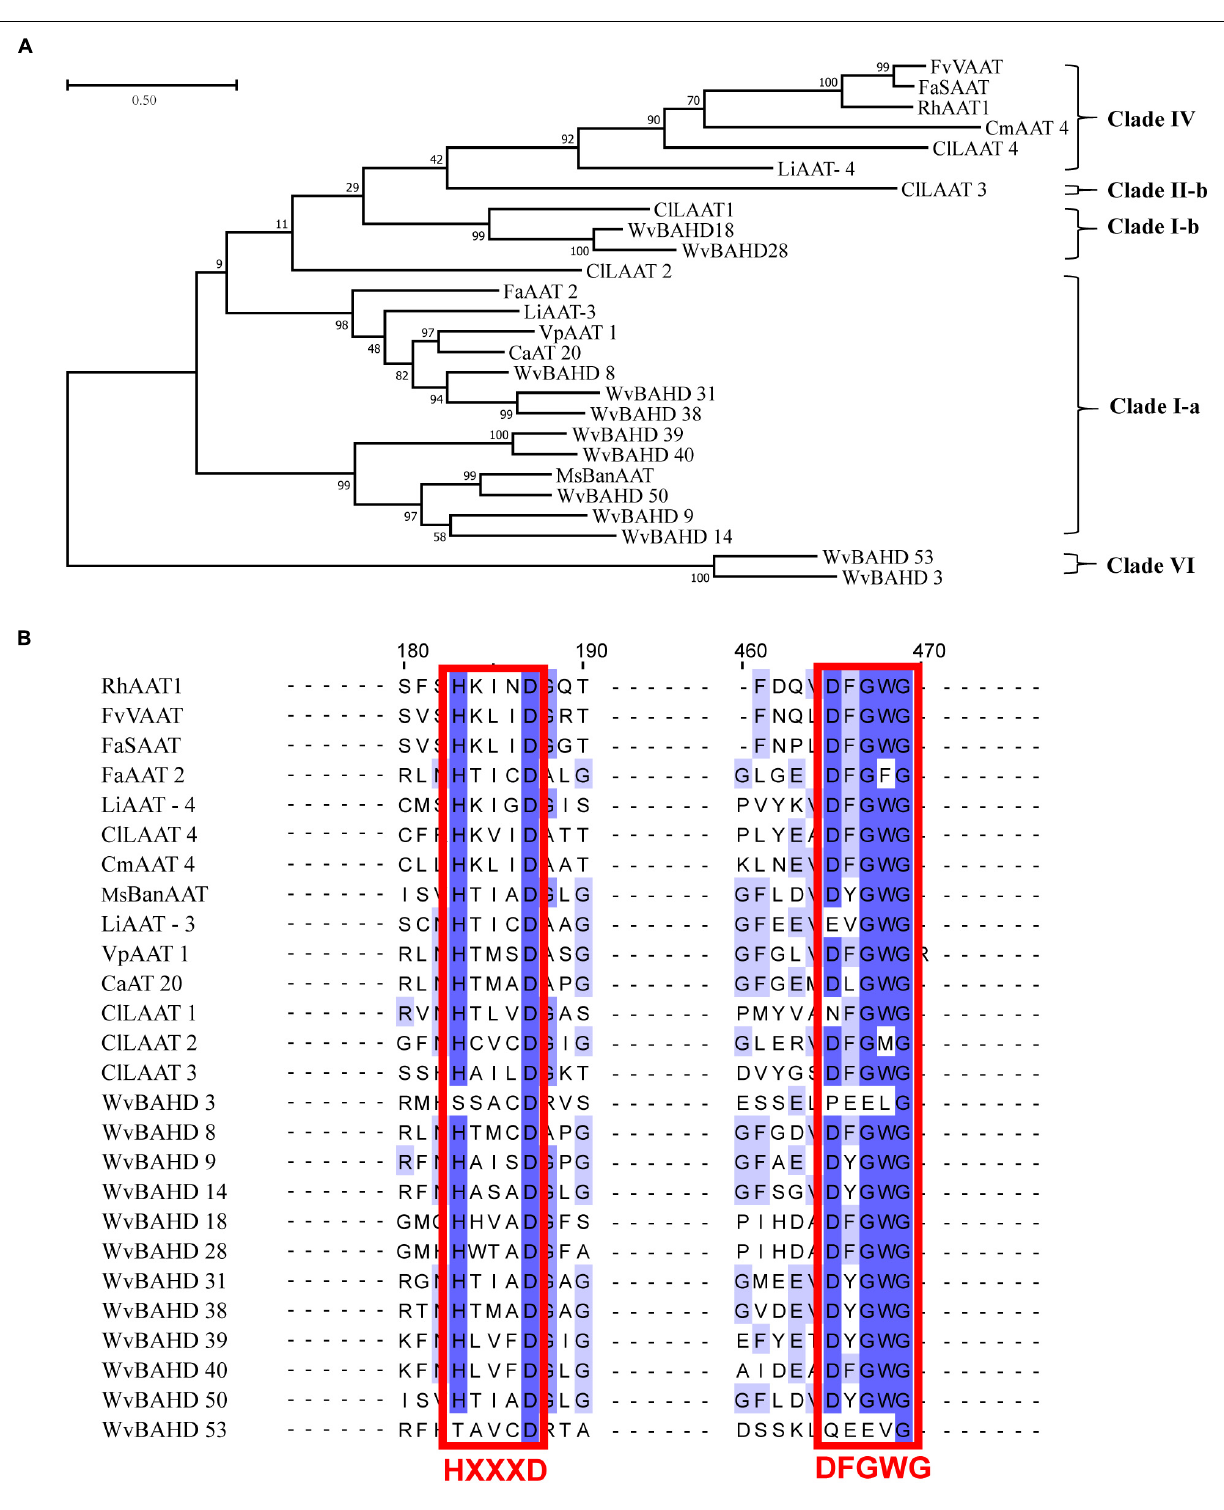
Frontiers in Plant Science |